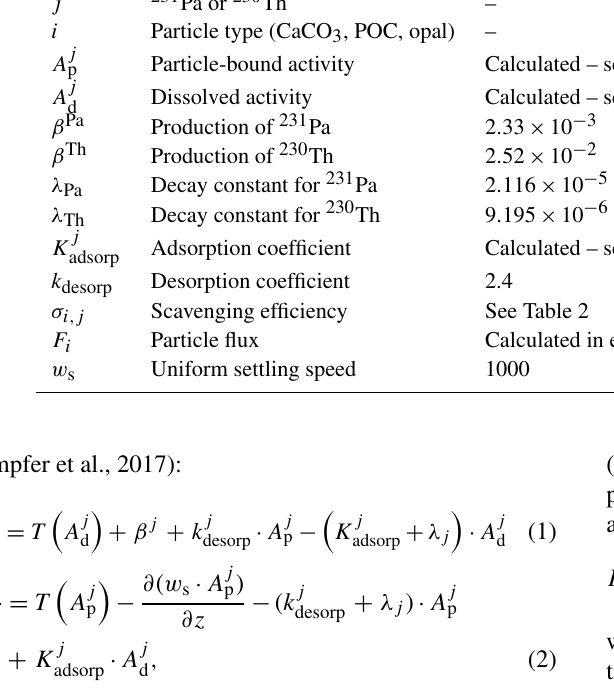
Table 1. Parameters used in the Pa / Th module. Symbol Variable Value Units j 231 Pa or 230 Th – – Particle type (CaCO 3 , POC, opal) – – A j p Particle-bound activity Calculated – see Eq.